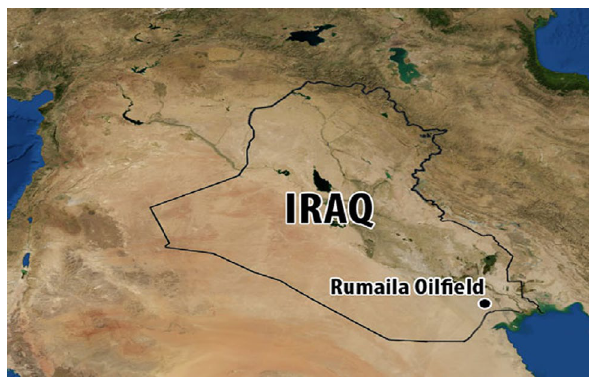
Fig. 1 Rumaila field (Parks